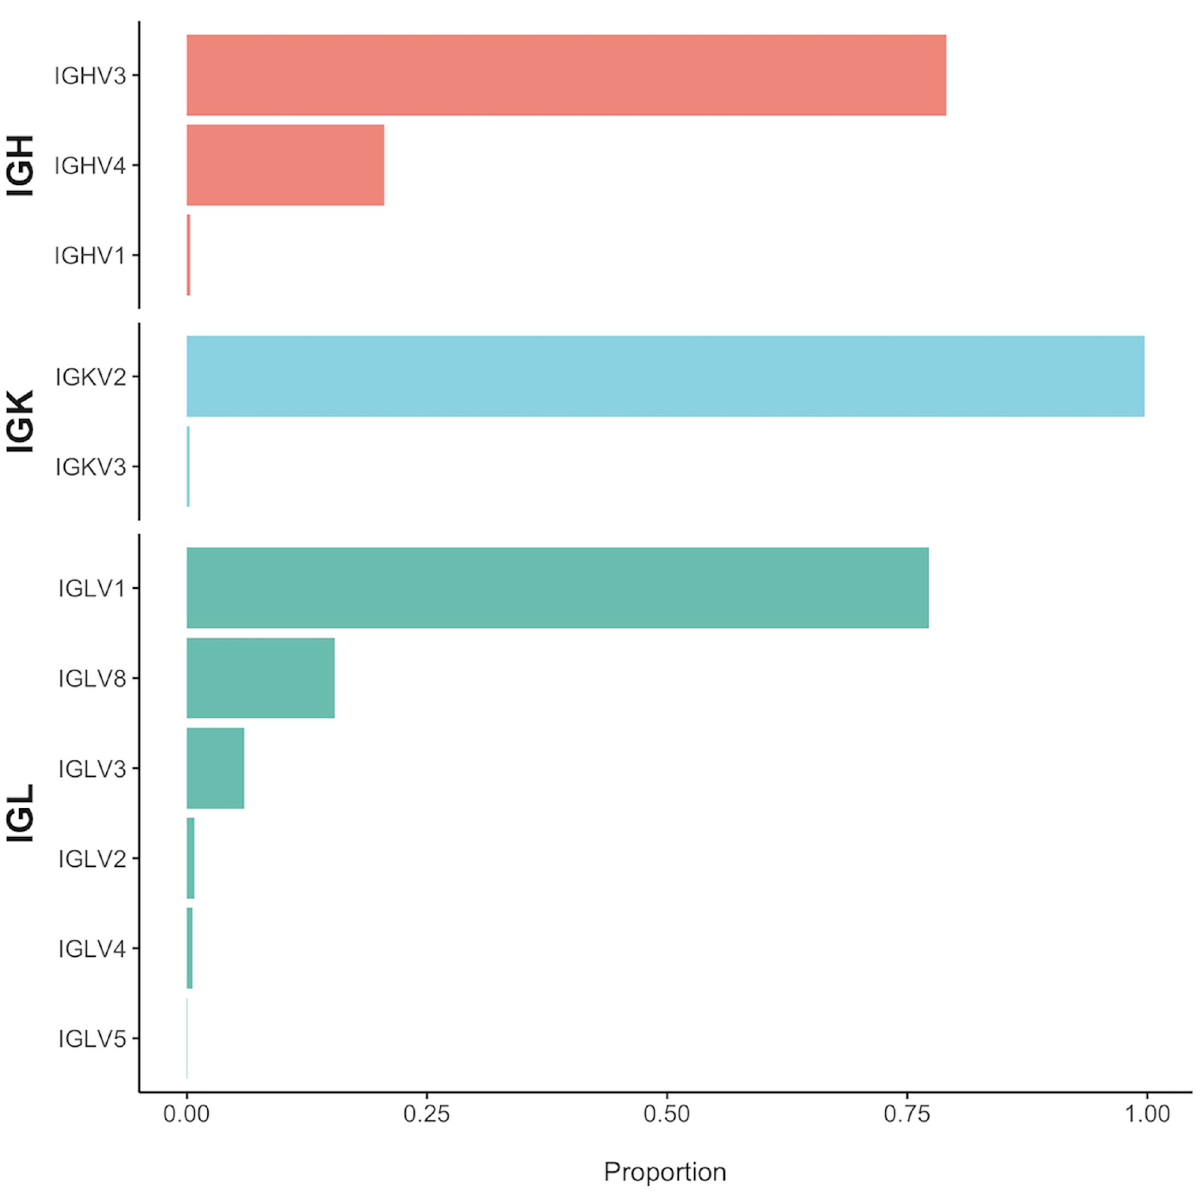
Fig 4. V gene usage by family. Proportion of V gene usage by family for IGH, IGK, and IGL.